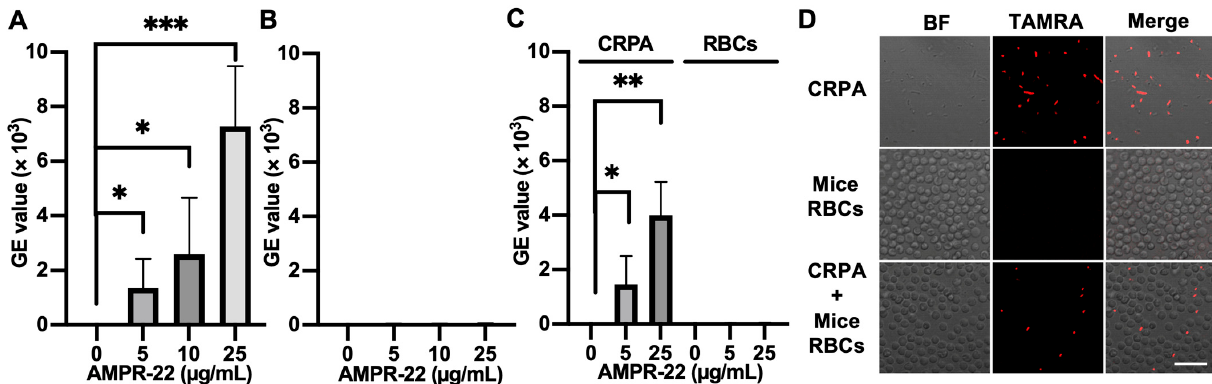
Figure 6. Interaction of TAMRA-labeled AMPR-22 with carbapenem-resistant P. aeruginosa (CRPA) or mouse red blood cells (RBCs). CRPA, mouse RBCs, or CRPA/RBCs group was incubated with TAMRA-labeled AMPR-22 for 10 min and analyzed via flow cy-tometry ( A – C ) or confocal micros- copy ( D ). Bars represent average ± standard deviation of three independent experiments. * p < 0.05, ** p < 0.01, *** p < 0.001 by unpaired t tests. BF, bright field; Scale bar, 20 µm.